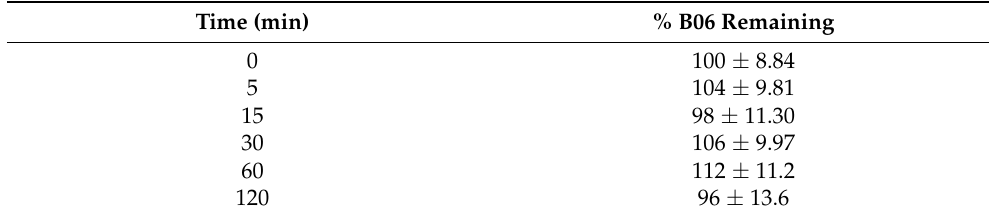
Figure 3. Chemical stability of B06 at pH = 2. Table 1. Percentage of B06 remaining at pH 2 versus time (0–120 min).